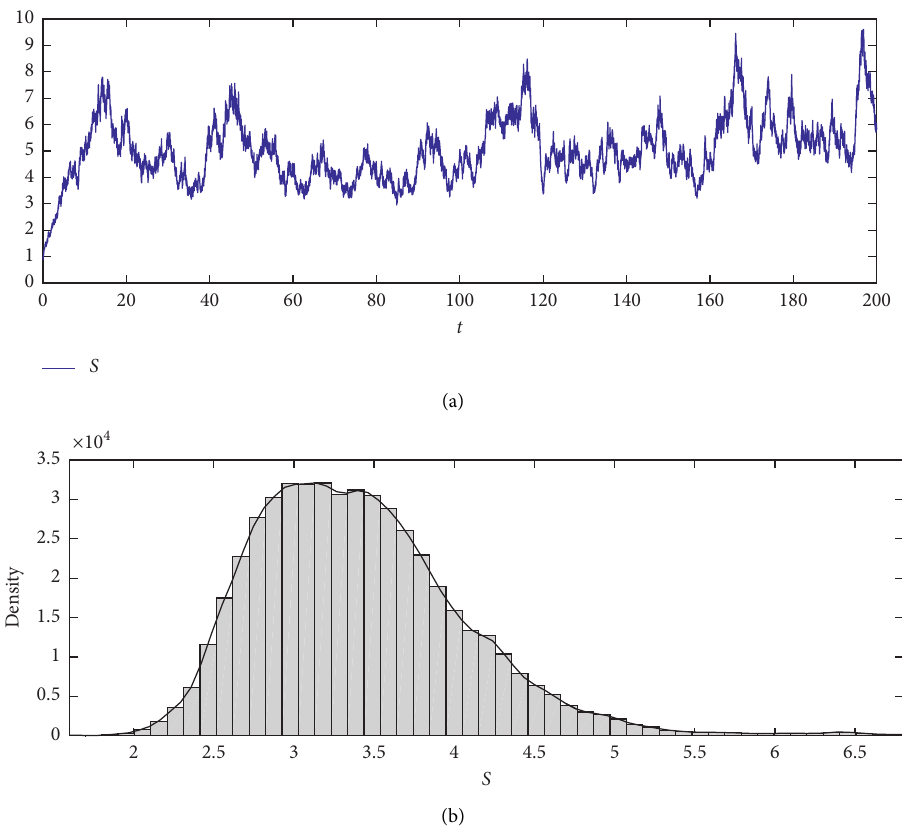
Figure 3: The solution S(t) of stochastic model (3) and its histogram.